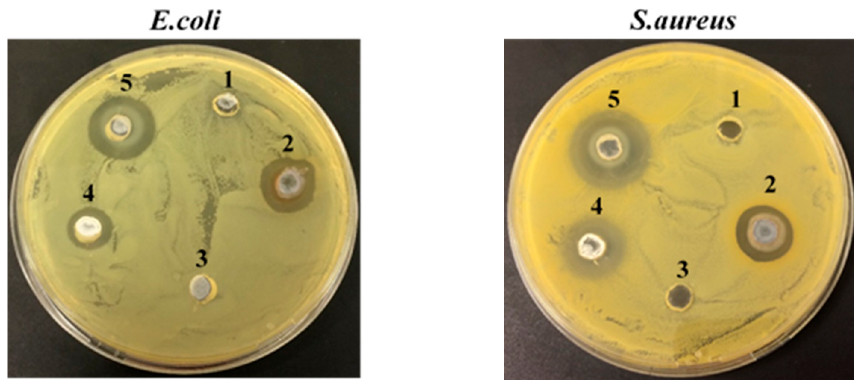
Figure 8. Comparison of inhibition zone of different solutions against E. coli and S. aureus bacteria. ( 1 ) PEG; ( 2 ) AgNPs solution (0.1 M AgNO 3 with PEG); ( 3 ) Distilled water; ( 4 ) ZnONPs solution (0.2 M Zn(CH 3 COO) 2 · 2H 2 O with distilled water); and, ( 5 ) ZnONPs solution (0.4 M Zn(CH 3 COO) 2 · 2H 2 O with distilled water).